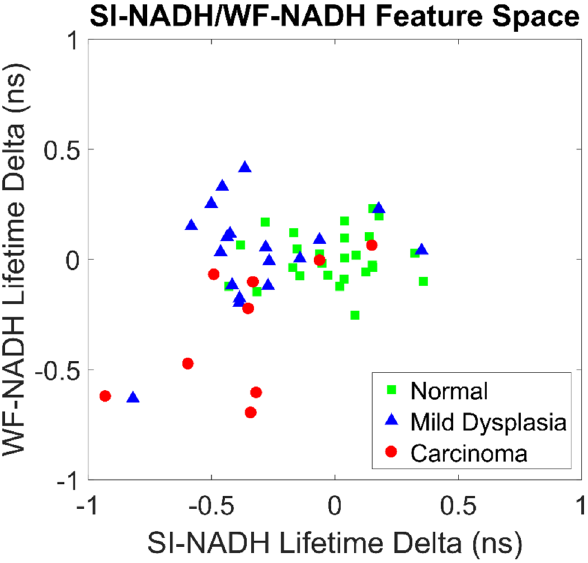
Figure 5. Feature space comparing the relationship between SI-NADH and WF-NADH for three diagnostic cases (normal, mild dysplasia, and carcinoma). Normal resides mostly around a zero delta from itself, as expected. Mild dysplasia shows displacement preferentially along the SI-NADH axis. Carcinoma shows displacement on both axes